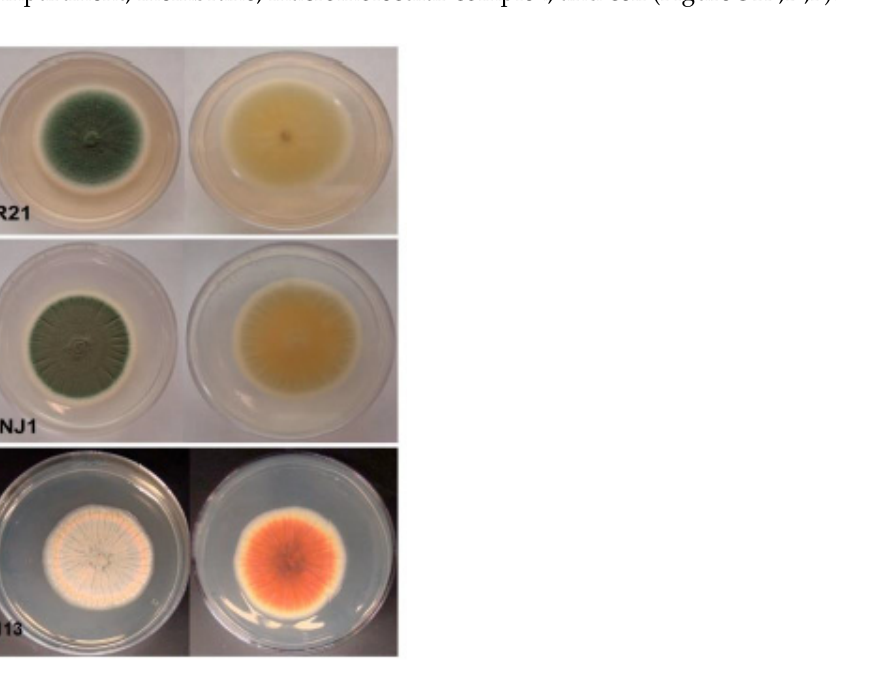
Figure 1. Morphology of P . expansum R21, P . crustosum NJ1, and P . maximae 113 colonies after cultivation for seven days on PDA at 25 ◦ C in the dark on the forward ( left ) and reverse ( right ) sides. Table 1. The assembly statistics and gene predictions. Penicillium spp. Assembly